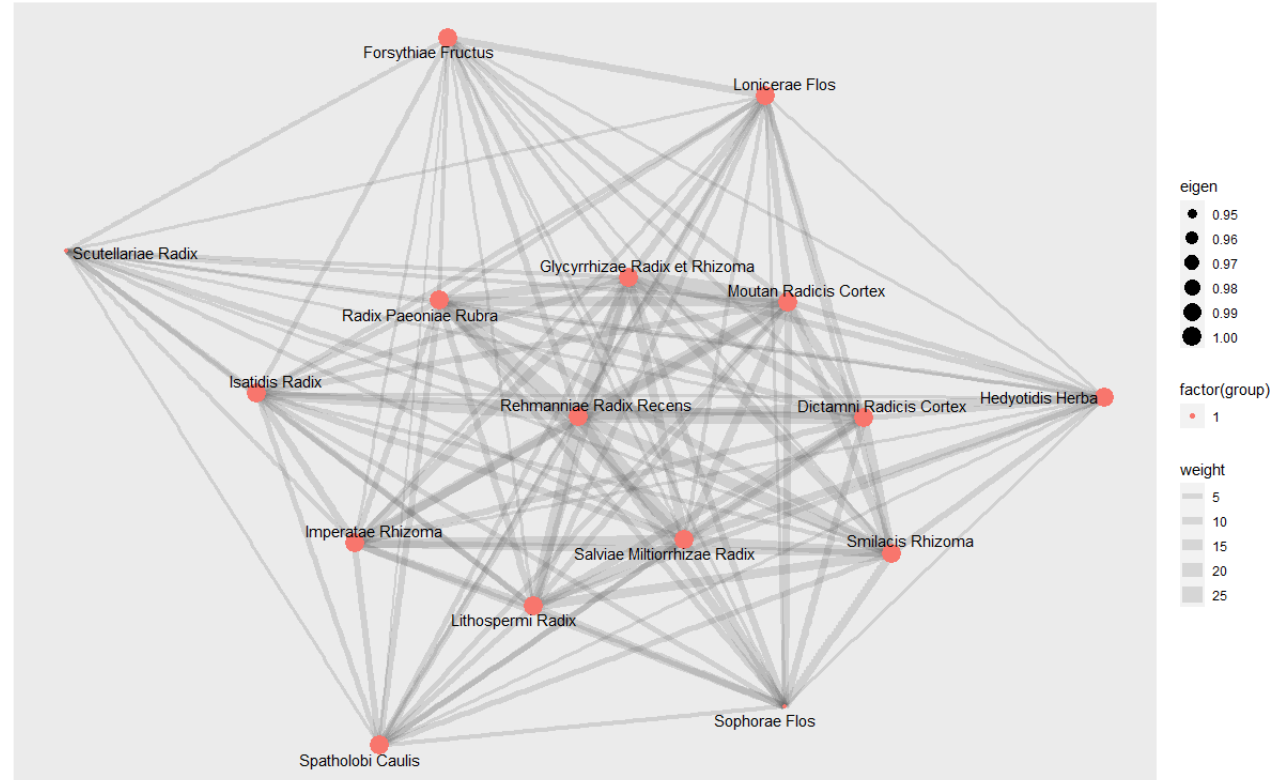
Figure 11. Core EAHM material network for treating psoriasis. The weight reflects the frequency at which two herbs are paired and utilized simultaneously in one EAHM prescription.